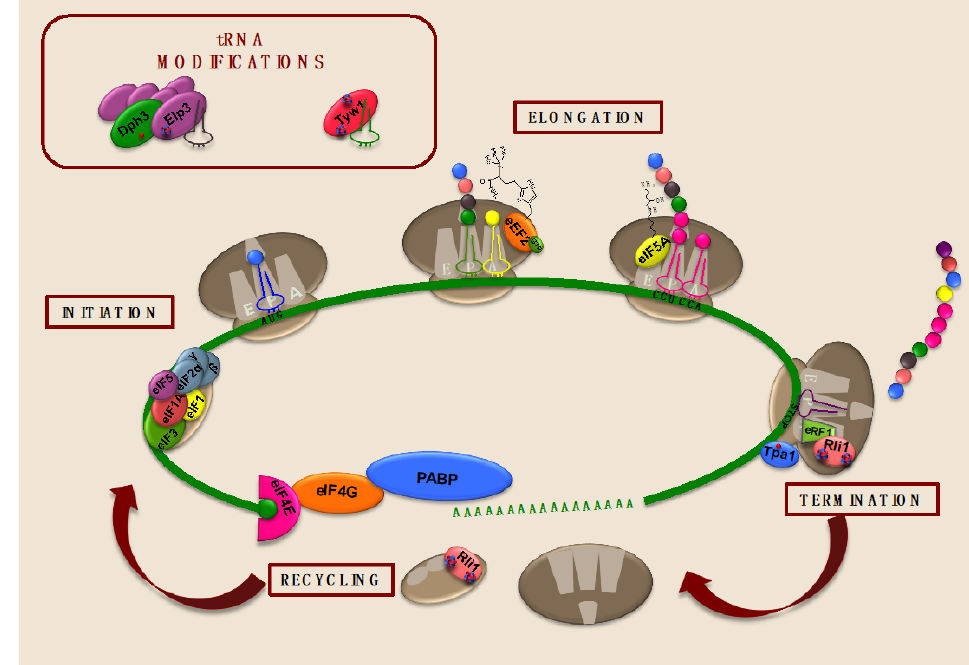
Figure 3. Iron-dependent proteins involved in the different steps of translation and in tRNA modifications in the budding yeast S. cerevisiae . In Rli1, Elp3, and Tyw1, ISCs are represented by red circles (iron nuclei) and blue circles (sulfur nuclei). Red circles in Dph3 and Tpa1 represent mononuclear iron cofactors.